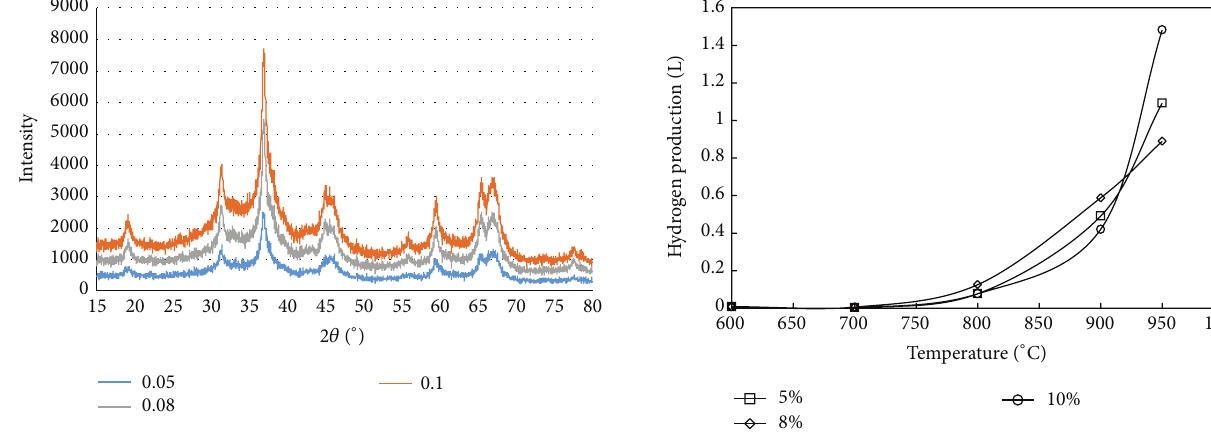
Figure 4: The catalytic activity of different cobalt loadings.